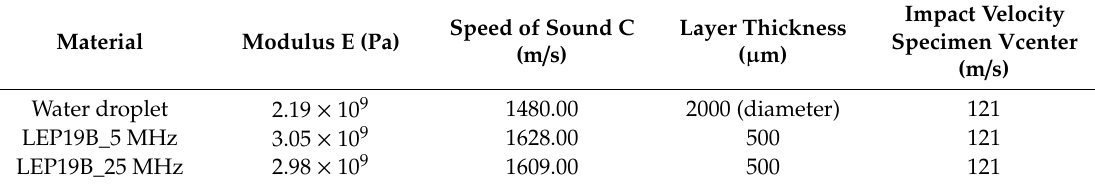
Table 3. Reference Input data used for the Lifetime Springer modelling in Case 3. DNVGL-RP-0171.